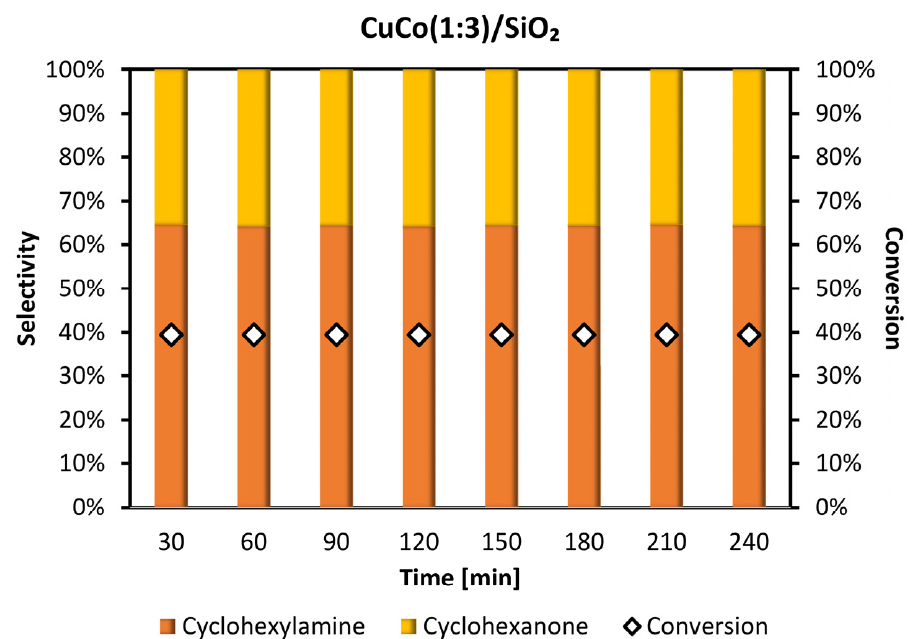
Figure 18. Catalytic hydrogenation of nitrocyclohexane in gas flow conditions with CuCo(1:3)/SiO 2 .